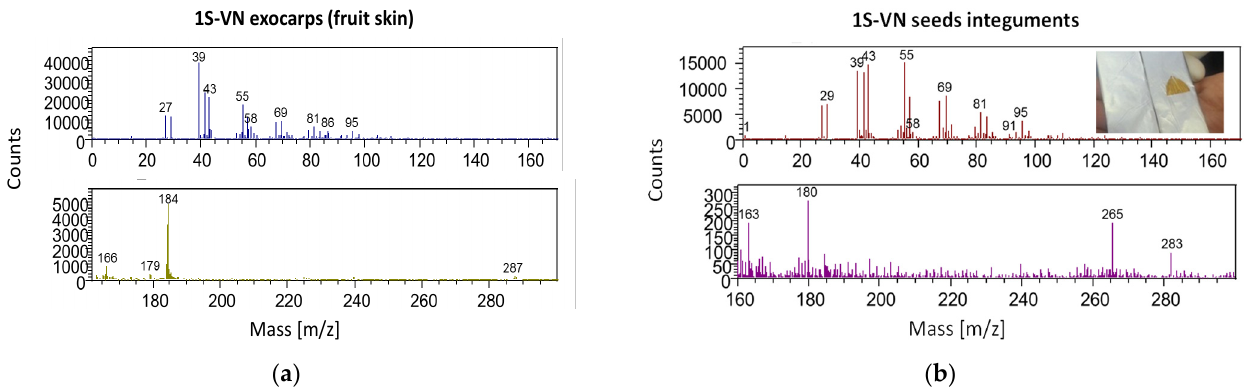
Figure 6. ToF-SIMS positive ion spectra of ( a ) exocarp (fruit skin) and ( b ) seed integument of sample 1S-VN.